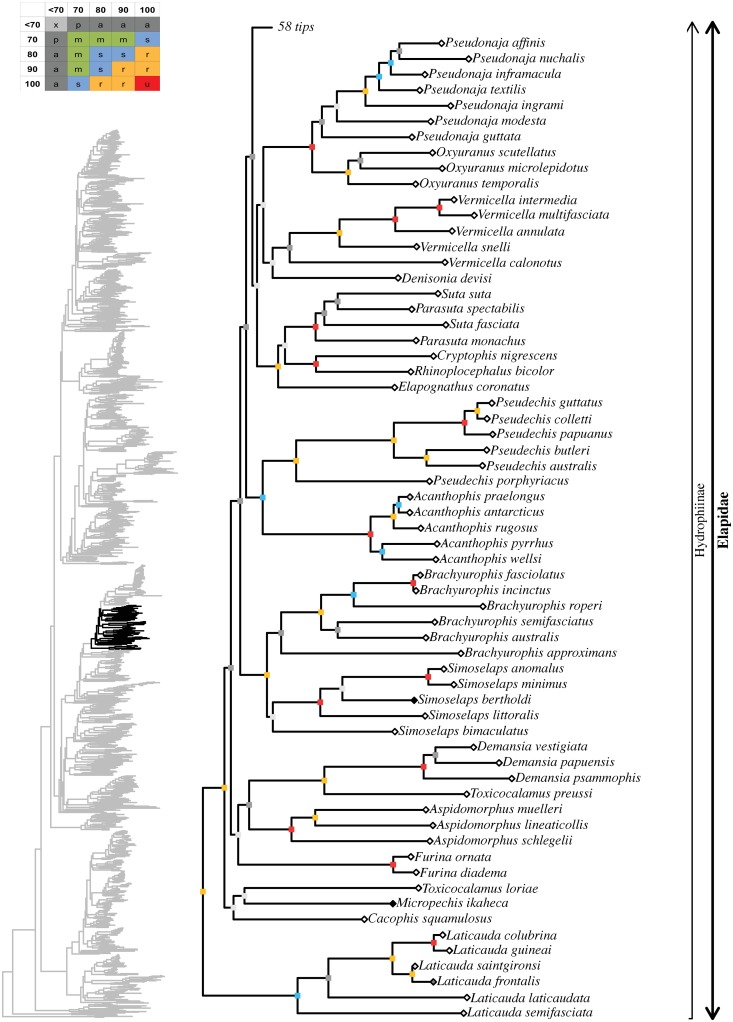
Maximum likelihood species-level phylogeny of Colubroides
(continued).Family Elapidae (continued).